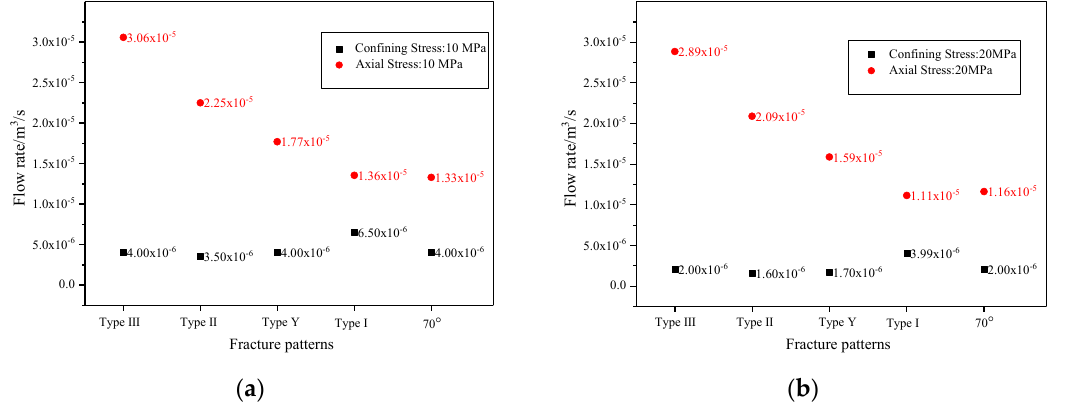
Figure 31. Contrast diagram of the seepage flow increment when the stress level changed from 30 MPa to 5 MPa. ( a ) 10 MPa and ( b ) 20 MPa.